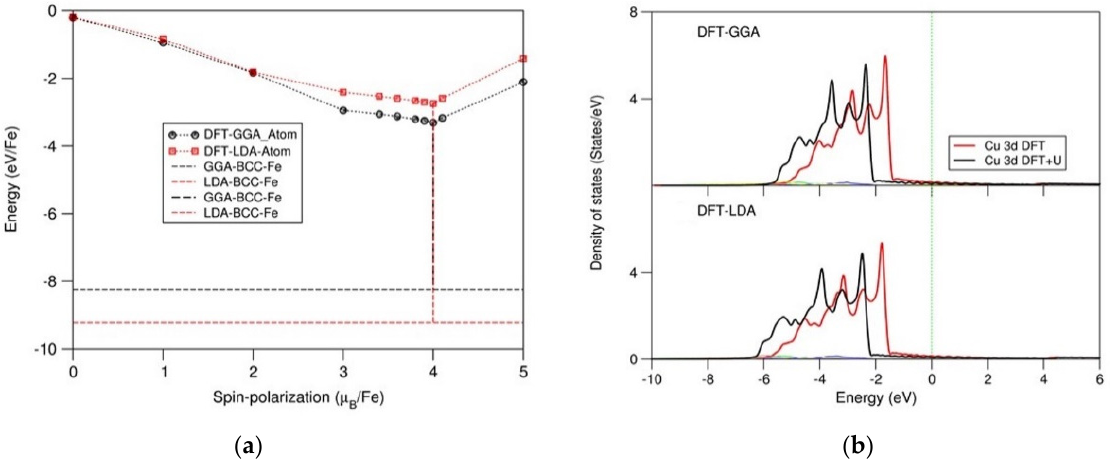
Figure 1. ( a ) (Color on line) The calculated energy on magnetic moment for an individual Fe atoms using the standard density functional, LDA and GGA. ( b ) The effect of on-site Coulomb interaction (U = 4 eV) on the Cu 3d states using both GGA ( top ) and LDA ( bottom ).